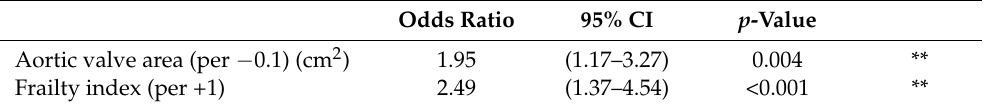
Factors that showed significant differences in the univariate analysis were analyzed using multiple logistic regression analysis. R 2 : 0.321; area under the curve of receiver operating characteristic (AUROC): 0.840; Akaike’s